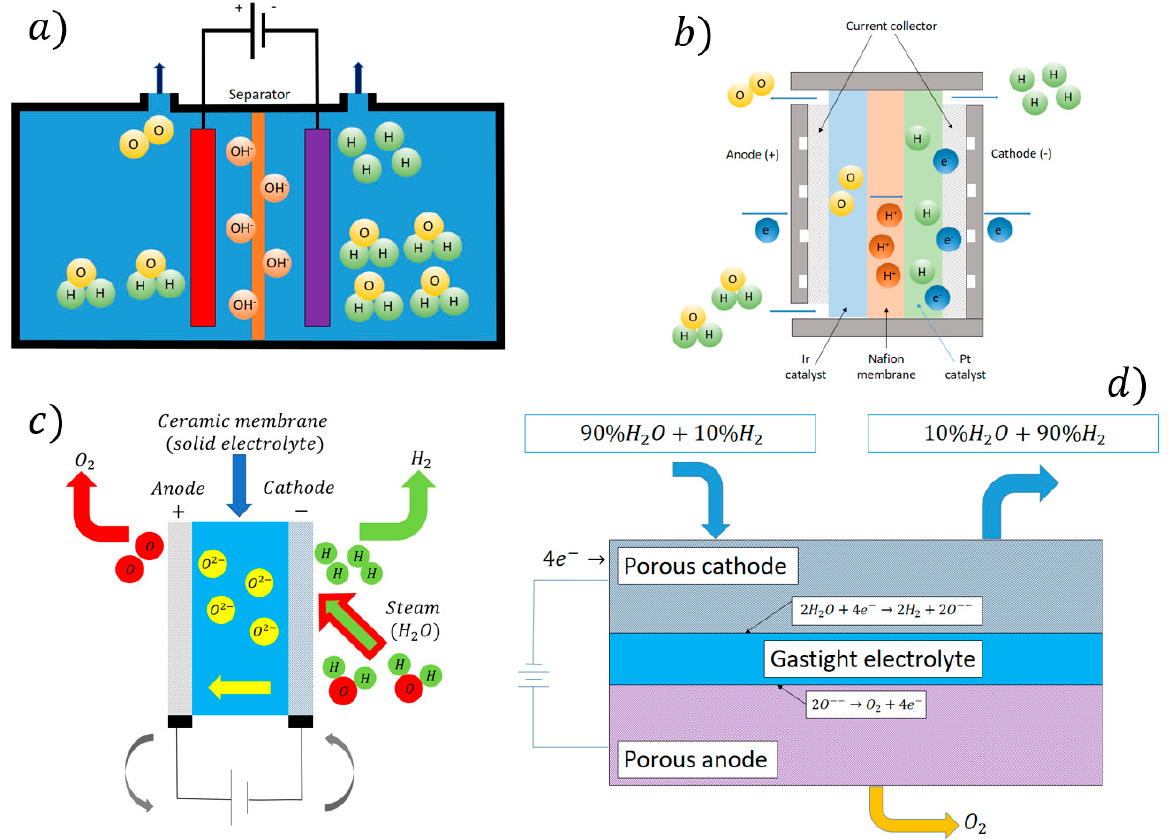
Figure 2. ( a ) Alkaline water electrolysis schematic; ( b ) PEMEL schematic; ( c ) SOEL schematic; ( d ) High-temperature steam electrolysis process schematic.